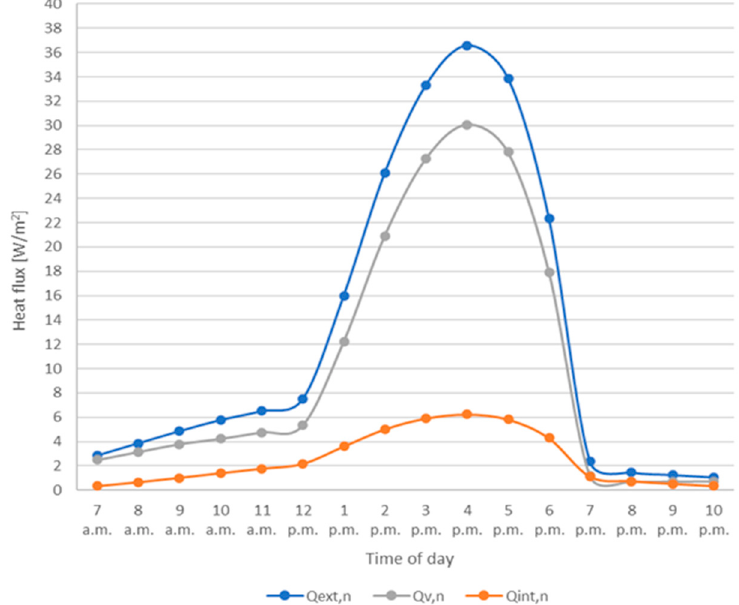
Figure 8. Hourly heat flux profiles obtained using the naturally ventilated façade: Q ext,n is the heat flux coming from the external environment into the cavity, Q v,n is the one removed by ventilation, and Q int,n is the heat flux that flows from the cavity to the internal environment.